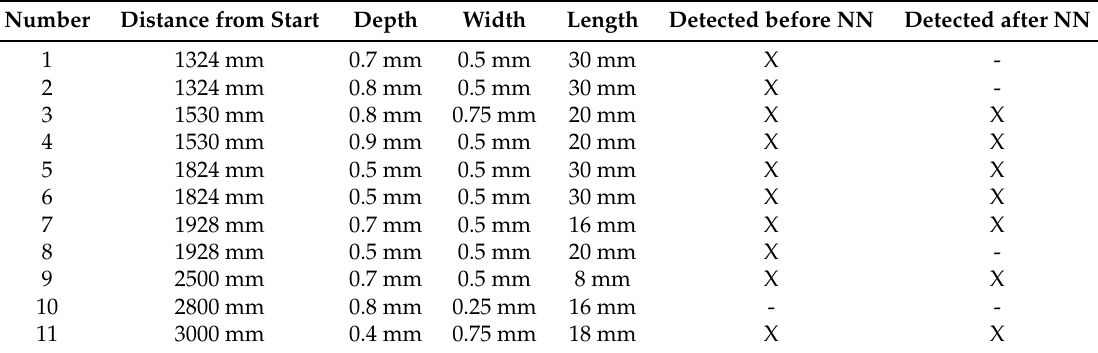
Table 3. Defects in the rail pattern.